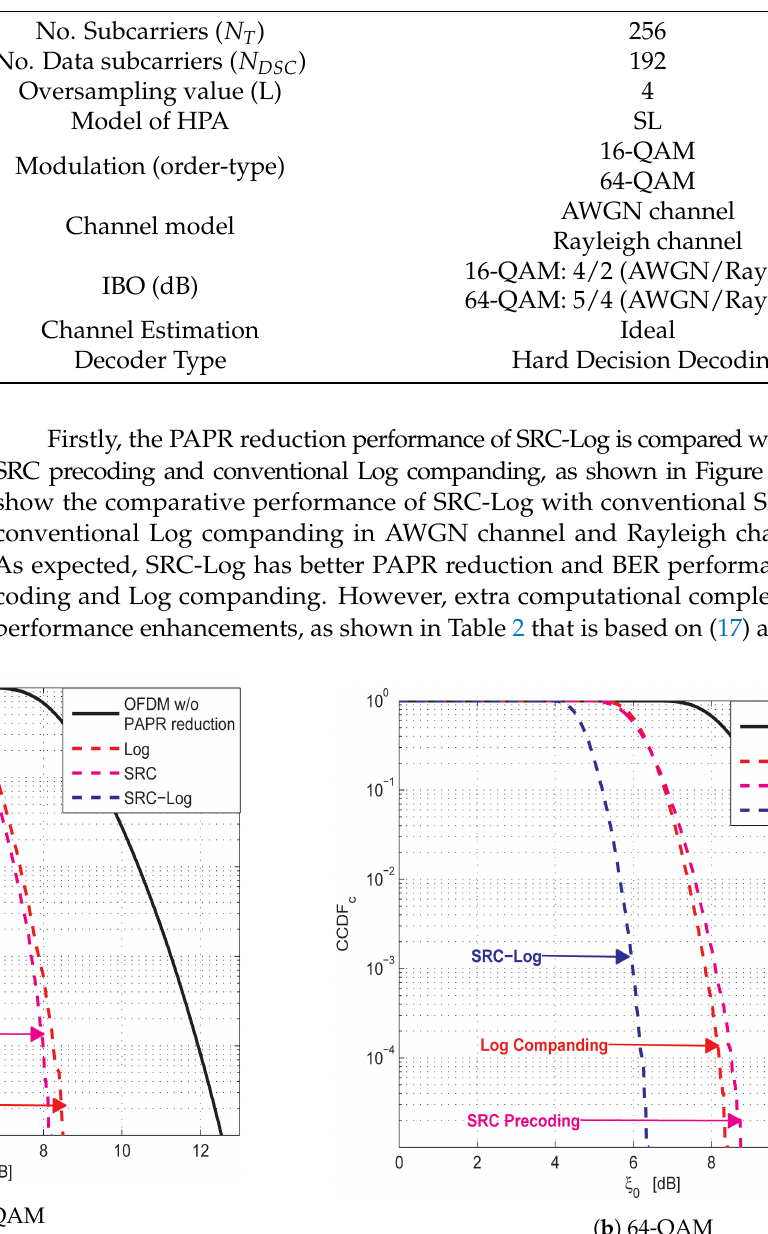
Figure 3. PAPR reduction capability comparison between proposed SRC-Log technique and conventional SRC precoding and Log companding